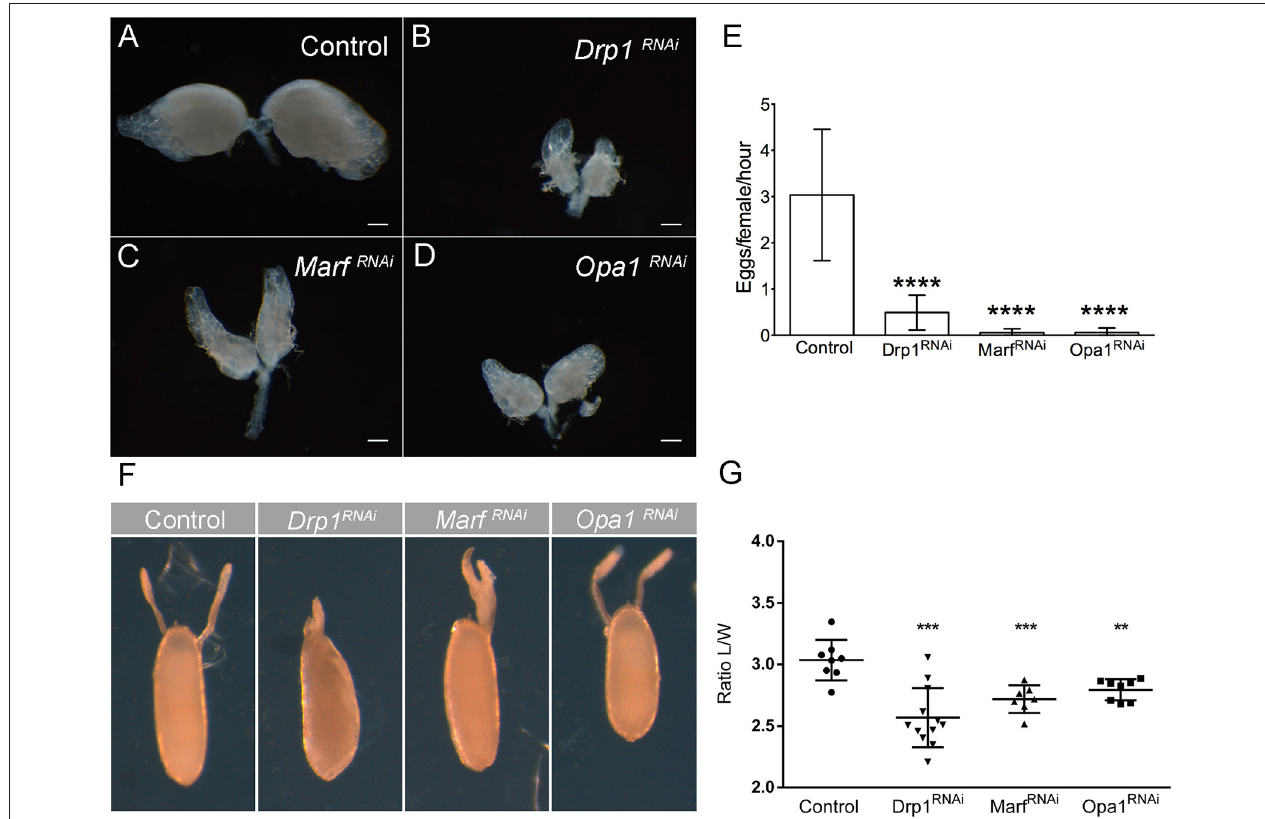
FIGURE 5 | Knockdown of Drp1 , Marf , or Opa1 in GSCs leads to reduced fecundity. (A–D) Ovaries of 1-day-old female virgins expressing Drp1 RNAi , Marf RNAi , or Opa1 RNAi in the germline by nos Gal4. (A) Bright-field images of whole ovaries of control ( mCherry RNAi ) females show normal ovary development and formation of mature eggs. (B–D) Drp1 RNAi , Marf RNAi , or Opa1 RNAi females have tiny ovaries containing mainly germaria-like structures and generally lacking mature eggs. Scale bars represent 200 µ m. (E) Quantification of the average number of eggs laid ( ± SD), per hour post-mating per female of the indicated genotype when crossed to wild-type males. Quantification revealed a significant decrease in fecundity of Drp1 -, Marf -, and Opa1 -knockdown females when compared with control ( mCherry RNAi ). (F) Representative images of dorsal appendage defects in eggs produced by females of the indicated genotypes. (G) Ratio Length/Width (L/W) (average ± SD) of the produced eggs. Eggs laid by Drp1- , Marf- , and Opa1 -knockdown females show smaller L/W ratio indicating abnormal egg morphology. Statistical significance of differences compared with control was calculated using simple sample t -test. ** P < 0.01; *** P < 0.001; **** P <